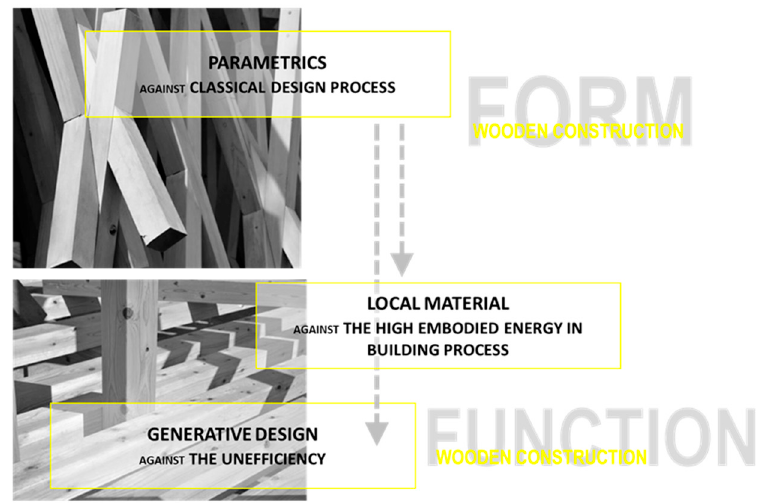
Figure 1. Research motivation. Background photos: ( top ) Joint system of Sunny Hills at Minami Aoyama by Kengo Kuma & Associates; ( bottom ) Tea house construction at The University of Ki- takyushu. Photograph by